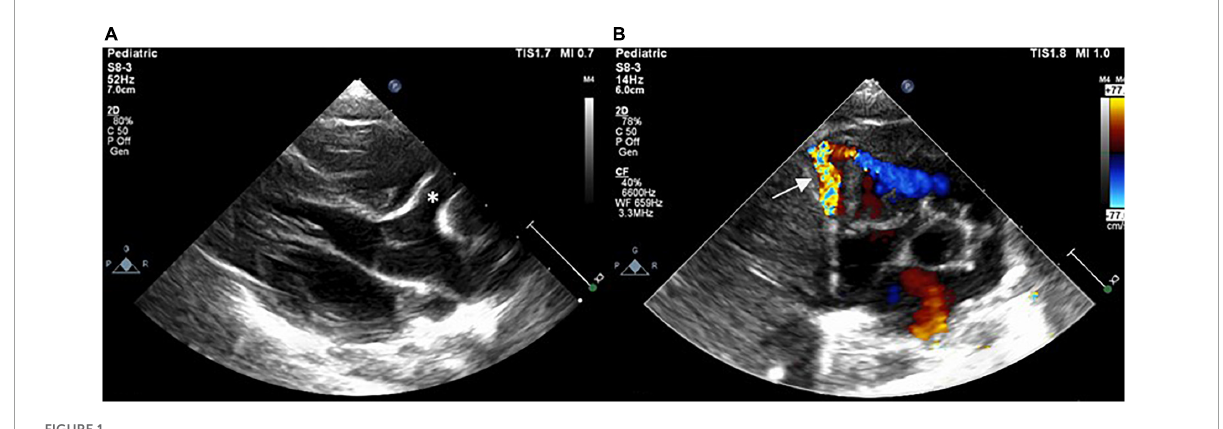
FIGURE1 Postnatal echocardiogram showing dilated RCA (asterisk) with a fistula (arrow) drained into the RV in (A) parasternal long-axis view and (B) short-axis view. RCA, right coronary artery; RV, right ventricle.